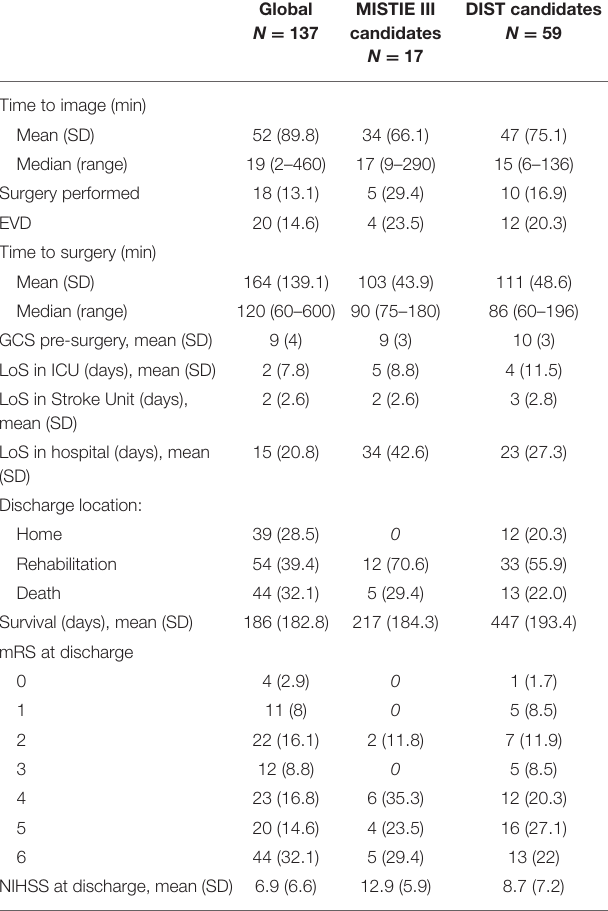
TABLE 2 | Data on clinical management, resources utilized and outcomes in the institutional